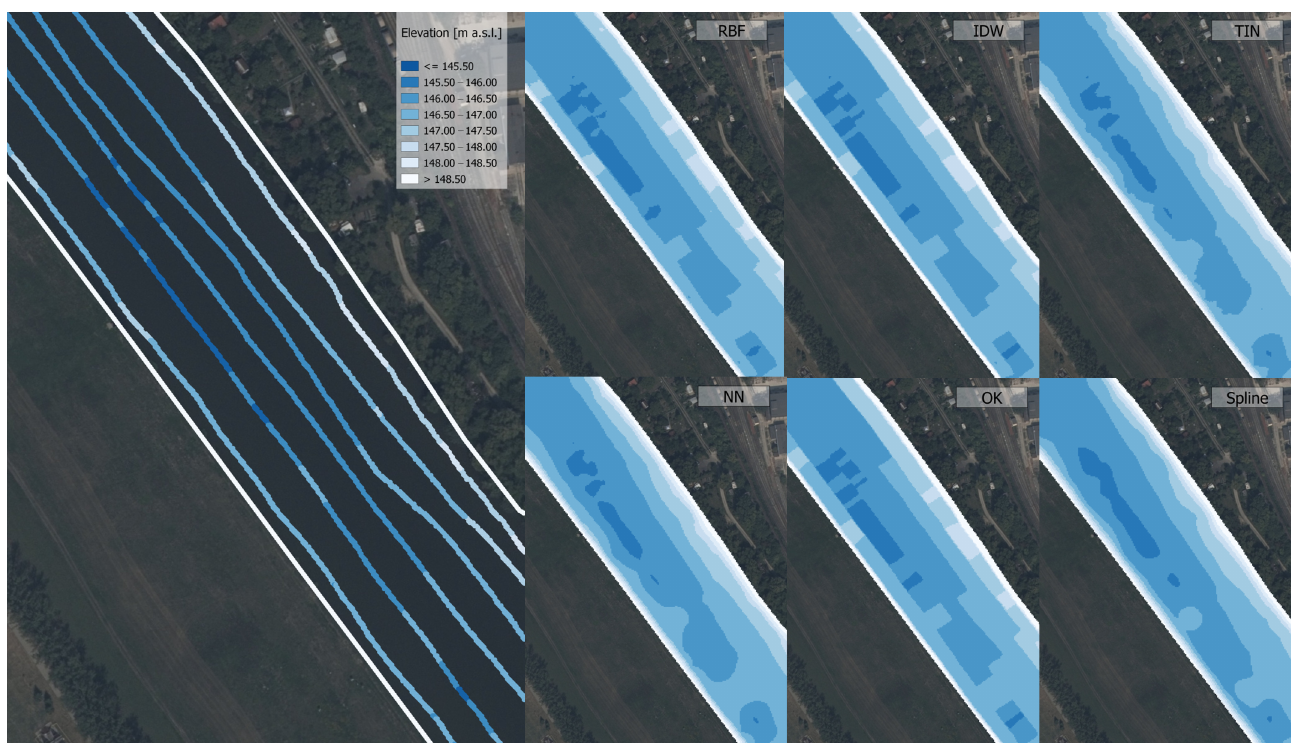
Figure 8. Example of RBMs generated for a small straight part of the Odra Cascade (reach from the barrage “Opole” to the barrage “Wróblin”) using six different interpolation